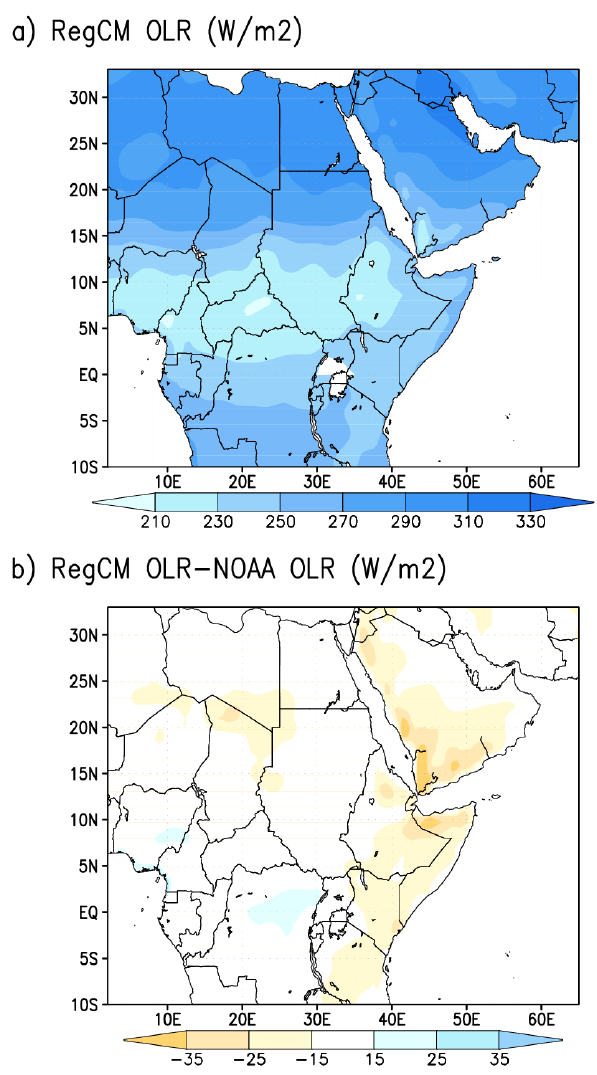
Figure 4. Averaged outgoing long-wave radiation (in Wm − 2 ) for JJAS 1982–2009: (a) Reg-TB OLR, (b) Reg-TB OLR minus NOAA OLR. Model data are ensemble